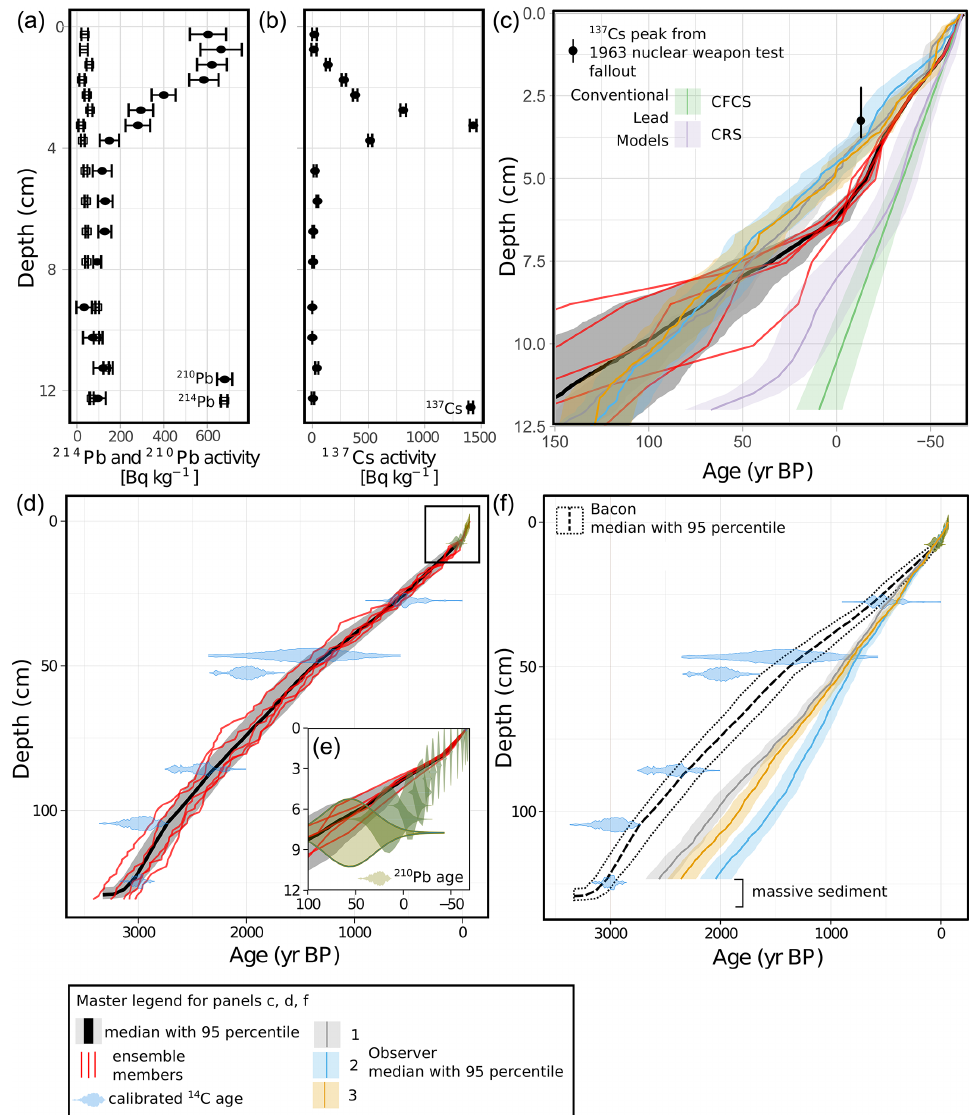
Figure 7. The chronology of Columbine Lake core COL17-3. (a) 210 Pb raw measurements. (b) 137 Cs raw measurements. (c) Comparison of lead models (green: CFCS, purple: CRS) and the caesium peak of the 1963 nuclear weapon test to the radiometric model (black, red, grey: Plum and Bacon) and to the varve-only model (light grey, blue, yellow: varve-only model). (d) Radiometric model produced from combining the Bacon-derived radiocarbon age–depth model with the Plum-derived lead age–depth model. Black and grey represent the median age with 95th percentile. The red lines represent five randomly selected ensemble members. Blue probability distribution functions represent the calibrated radiocarbon ages. (e) Plum-derived lead age–depth model. Brown probability distribution functions represent the sampled 210 Pb ages. (f) Comparison of the radiometric model (Bacon and Plum combined) to the varve-only models for each observer. Panel (c) shows the same area of the graph as panel (e)